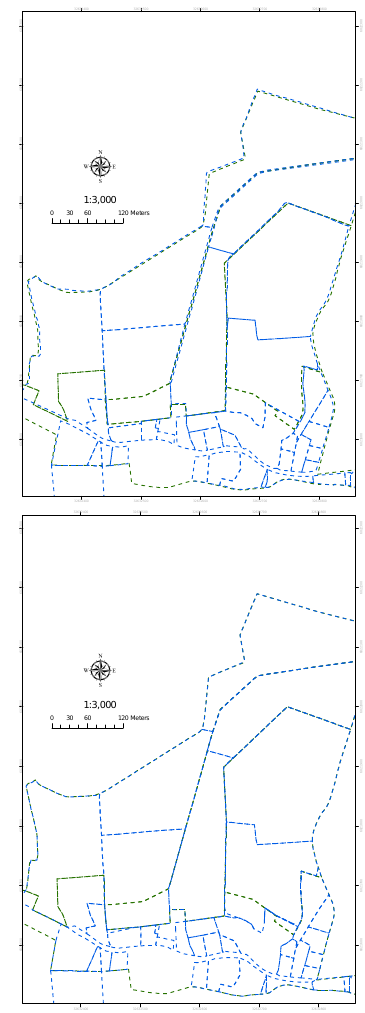
Figure 6. Alignment of road network databases with up to 50 meters of discrepancies: before (left) and after (right)